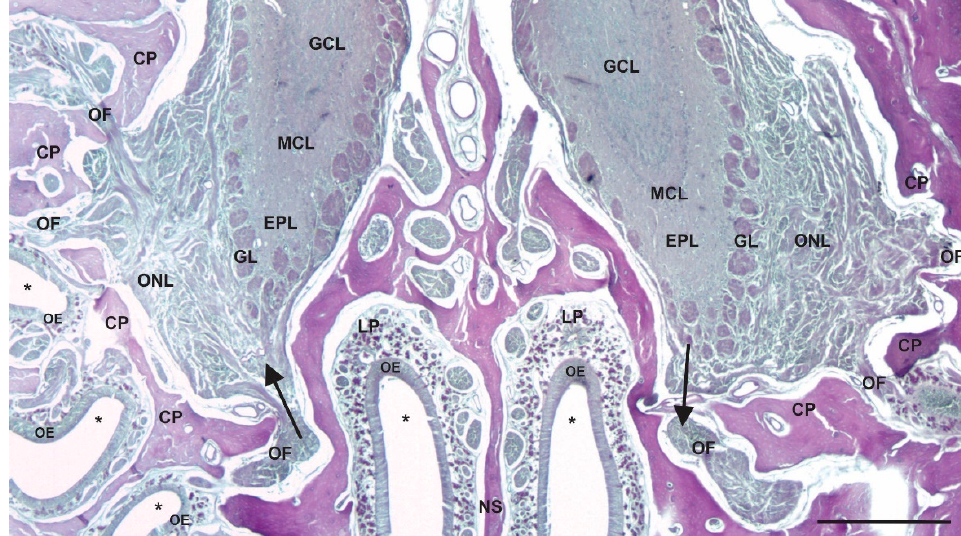
Figure 2. Route for centripetal and centrifugal transport between the olfactory epithelium and olfactory bulbs. A decalcified coronal section of the bony cribriform plate (CP) of the skull, the bony nasal septum (NS), and the superior part of the NC stained with periodic acid–Schiff reagent (asterisks indicate airspace of the NC). The olfactory nerve fascicles (OFs) pass through holes of the CP connecting the olfactory sensory neurons of the olfactory epithelium (OE) to the glomeruli (GL) of the olfactory bulbs in the CNS. The axons of the olfactory sensory neurons collect into nerve fascicles in the lamina propria (LP) of the superior NC. Note the relatively short and direct route these axons take from the epithelium to the brain. The arrow on the left indicates the direction of centripetal spread, while the arrow on the right indicates the direction of centrifugal spread. GCL = granule ‐ cell layer; MCL = mitral ‐ cell layer; EPL = external plexiform layer; GL = glomerular layer; ONL = olfactory ‐ nerve ‐ fiber layer. Scale bar = 400 μ m.